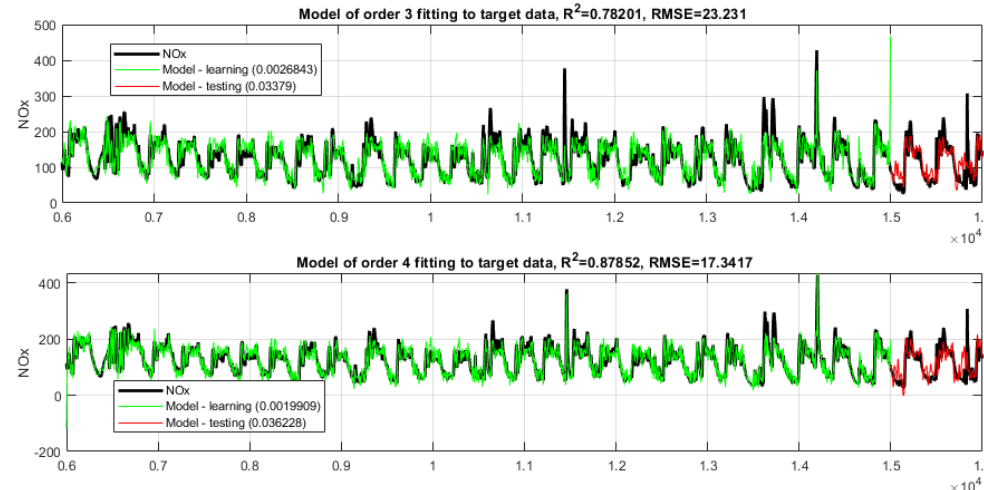
Figure 8. Orders 3 and 4, selected 10